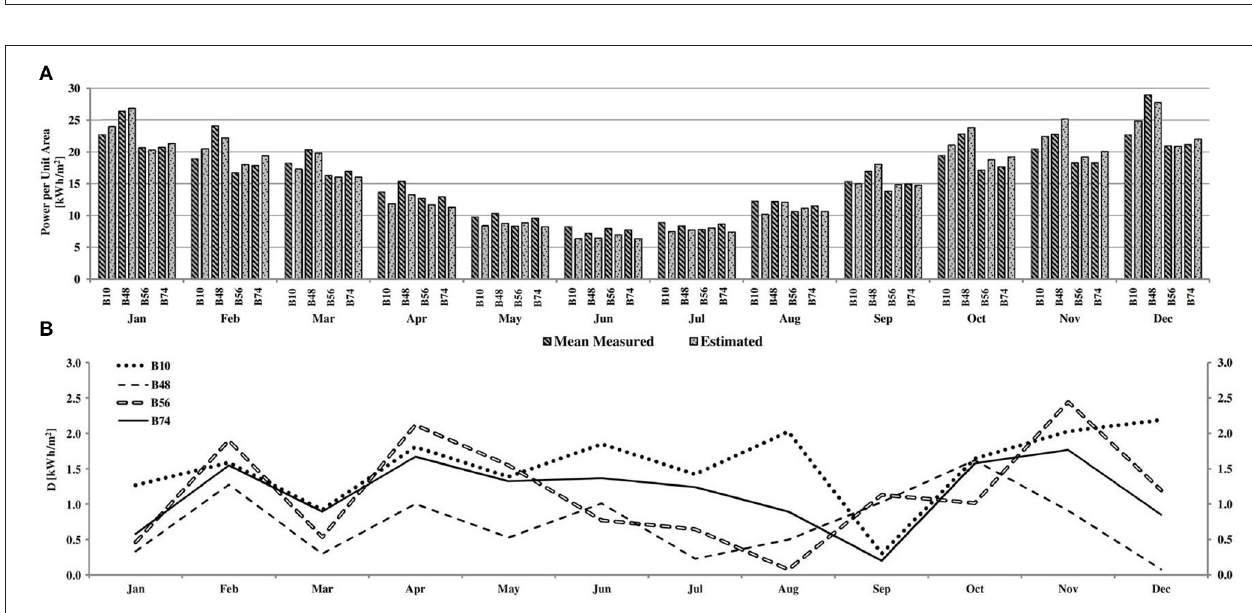
FIGURE 10 | Monthly and annual solar irradiation values for the selected rooftops.